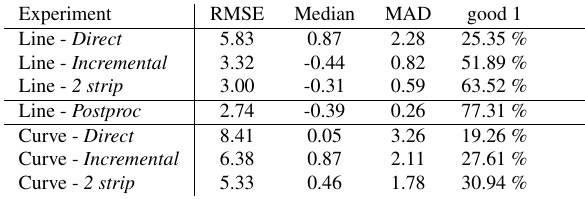
Table 1. Height difference statistics between different real-time DSMs and LiDAR point cloud in meters. Median reports report absolute height error, median absolute deviation (MAD) report relative differences. RMSE and good 1 (percentage of DSM pixels within 1m of the LiDAR point cloud) indicate the overall